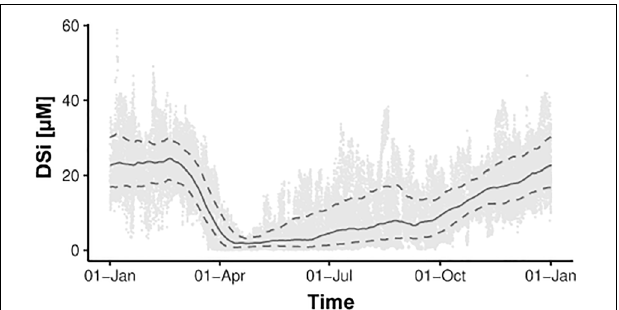
FIGURE 3 | Seasonal DSi dynamics in the water column of the Spiekeroog tidal basin. The solid line indicates the moving average of the time-dependent median including data from 2007 to 2017 and reflects typical seasonal DSi variations occurring every year. The dashed lines show the 10 and 90%